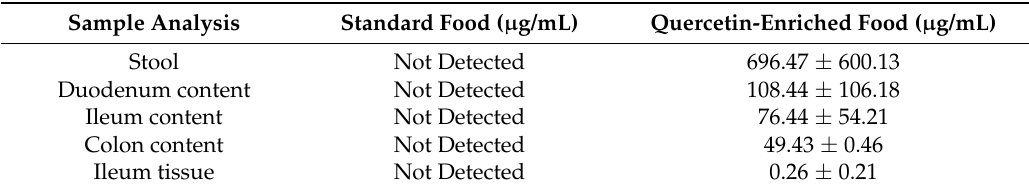
Table 1. Quantification of quercetin in stool samples from different regions of the intestine obtained by liquid chromatography-mass spectrometry (LC-MS). Mean values for mice fed with standard and quercetin-enriched food are expressed in µ g/mL for fecal sample and ng/10 mg for ileum tissue.